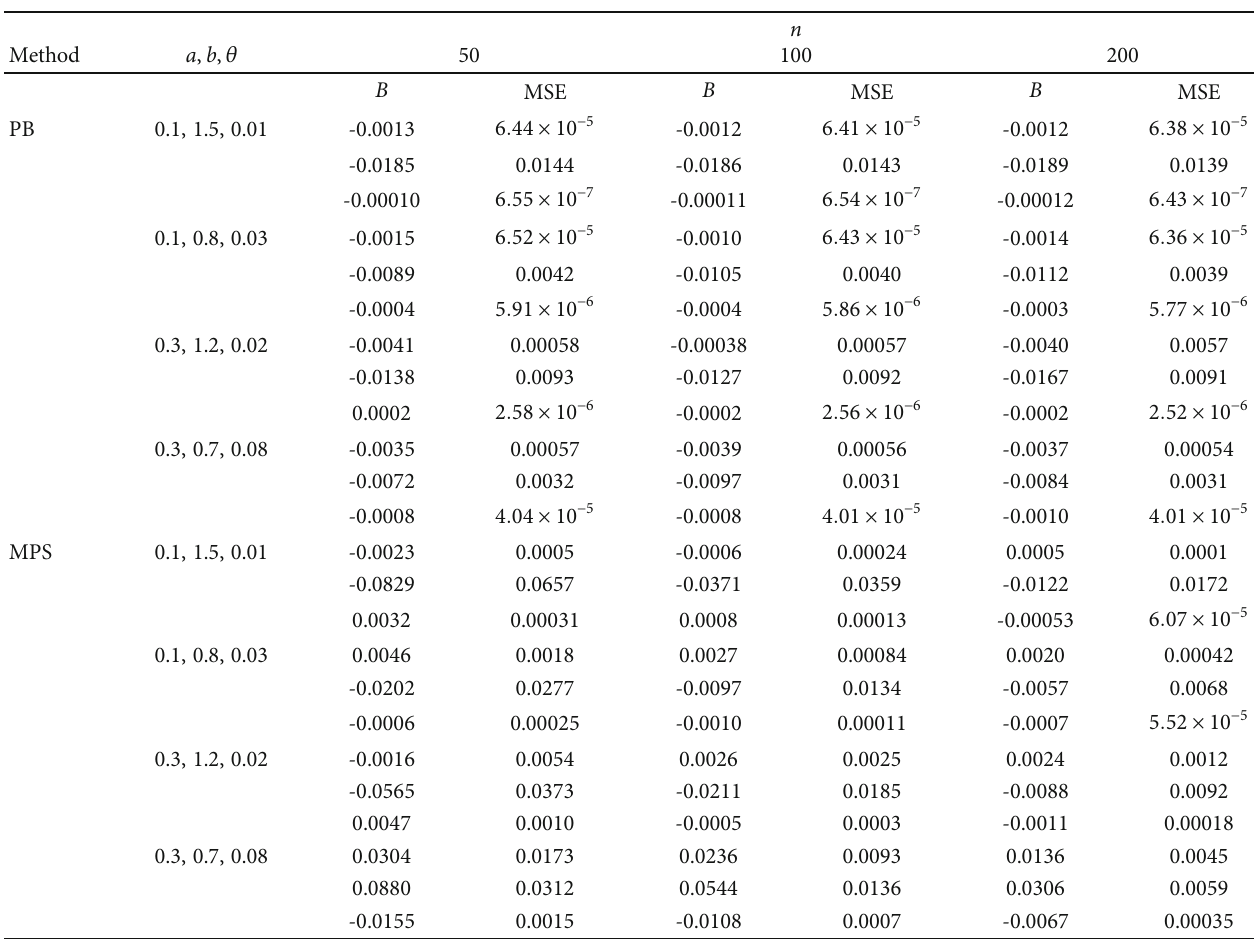
Table 3: The bias and MSE of the PB and MPS computed by a simulation study. Every cell consists of B in the second row, and B θ and MSE θ in the third MSE b